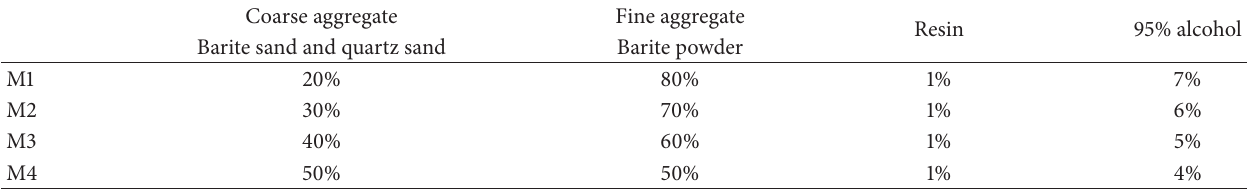
Table 2: Design mix proportions (groups).